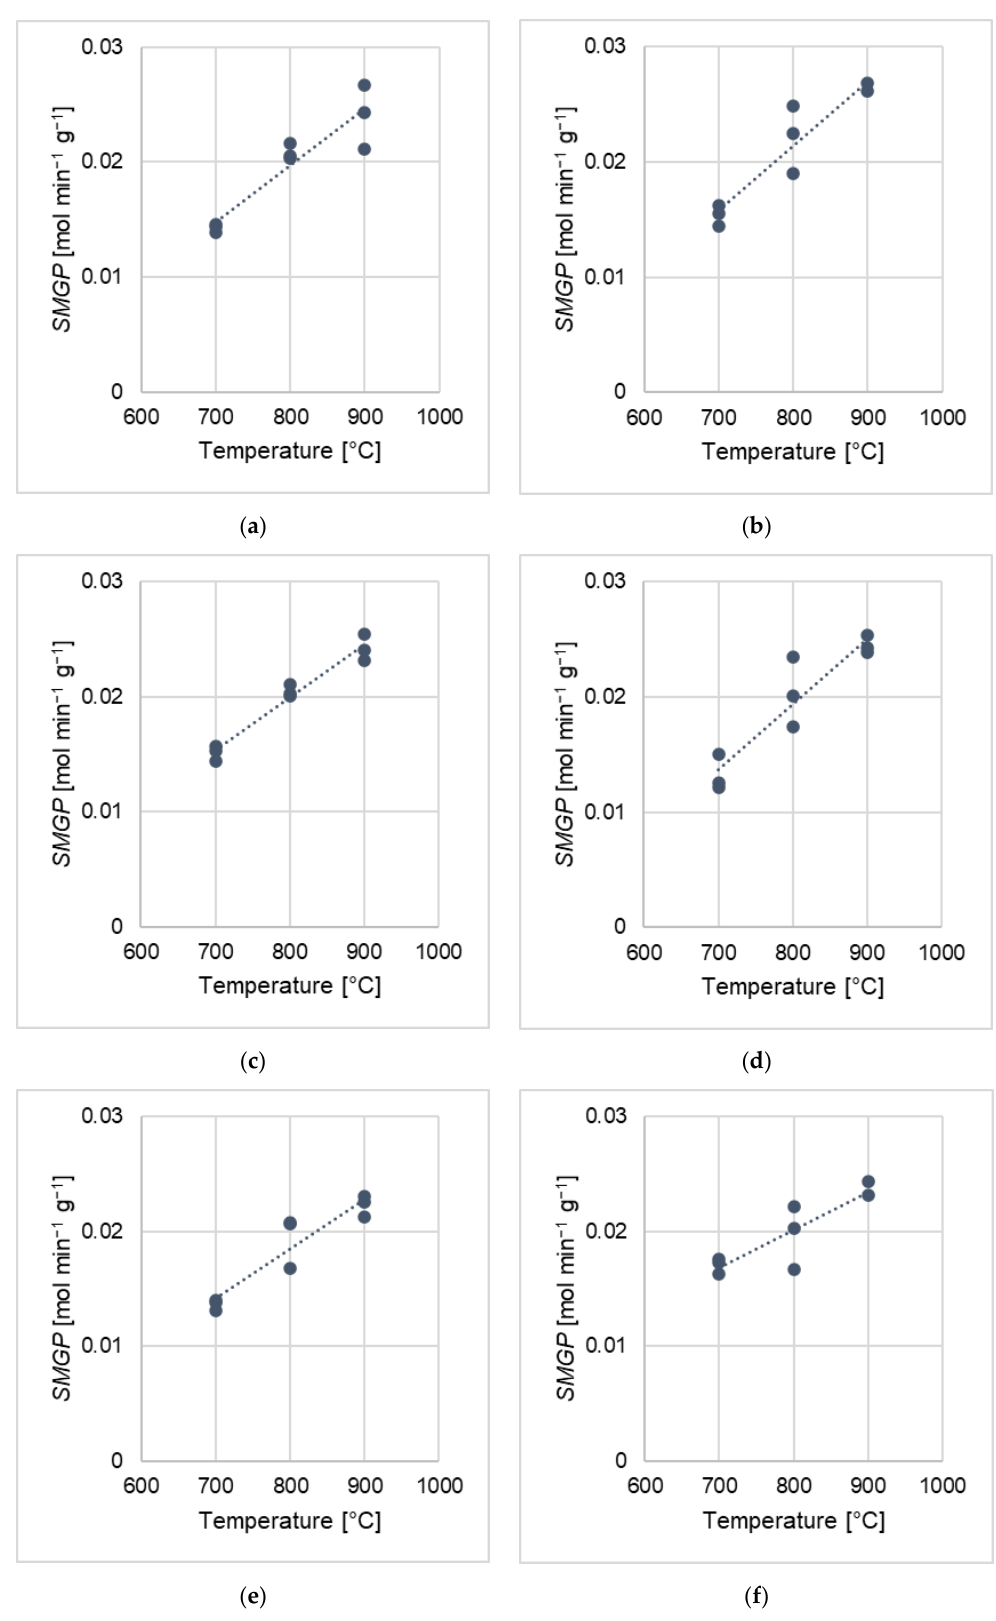
Figure 5. Experimental results from devolatilizations of torrefied and torrefied-washed pellets. SMGP (Equation (6)) as a function of temperature (points), with regression straight lines (dotted), for: ( a ) WSP-T1; ( b ) WSP-T1W; ( c )